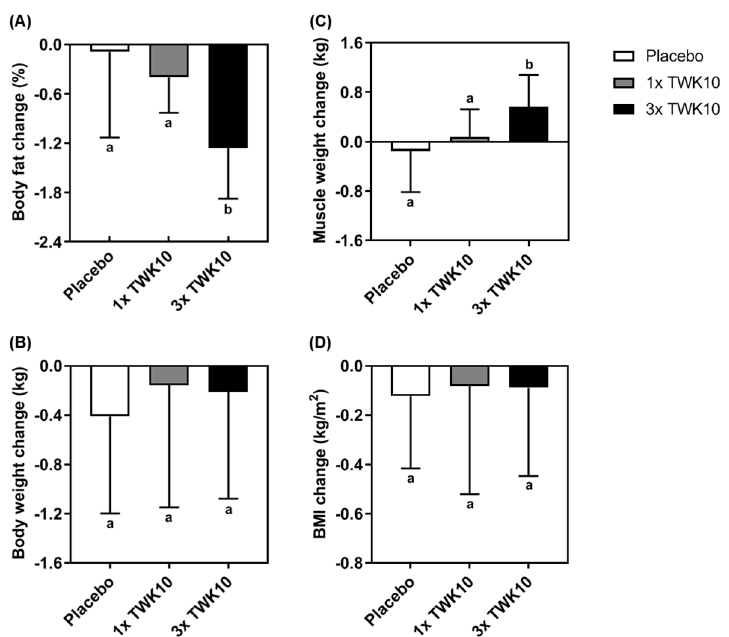
Figure 6. TWK10 exerted beneficial effects on body composition. The changes in ( A ) body fat, ( B ) weight, ( C ) muscle weight, and ( D ) BMI were calculated as the di ff erence between after and before body weight, ( C ) muscle weight, and ( D ) BMI were calculated as the difference between after and administration and are shown as the mean ± SD. Statistical di ff erence among groups was analyzed before administration and are shown as the mean ± SD. Statistical difference among groups was using the Kruskal–Wallis test, and di ff erent letters (a, b) indicate a significant di ff erence at P < analyzed using the Kruskal–Wallis test, and different letters (a, b) indicate a significant difference at P < 0.05.